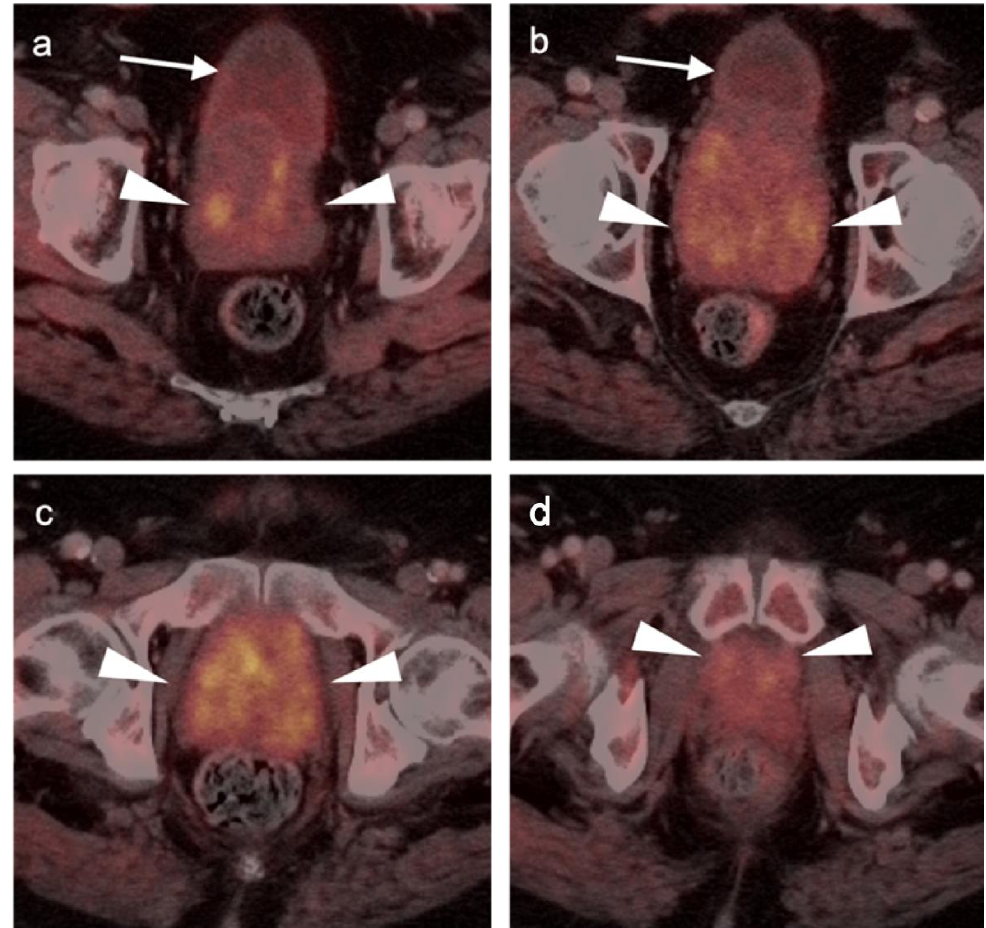
tive in both cases (white arrowheads).